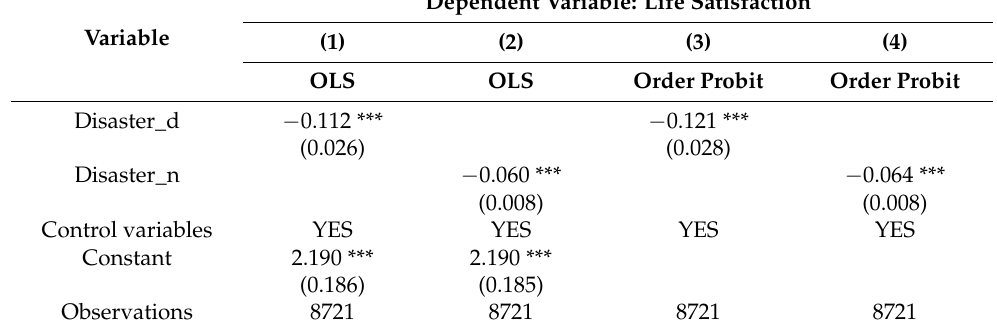
Table 10. Natural disasters and life satisfaction.